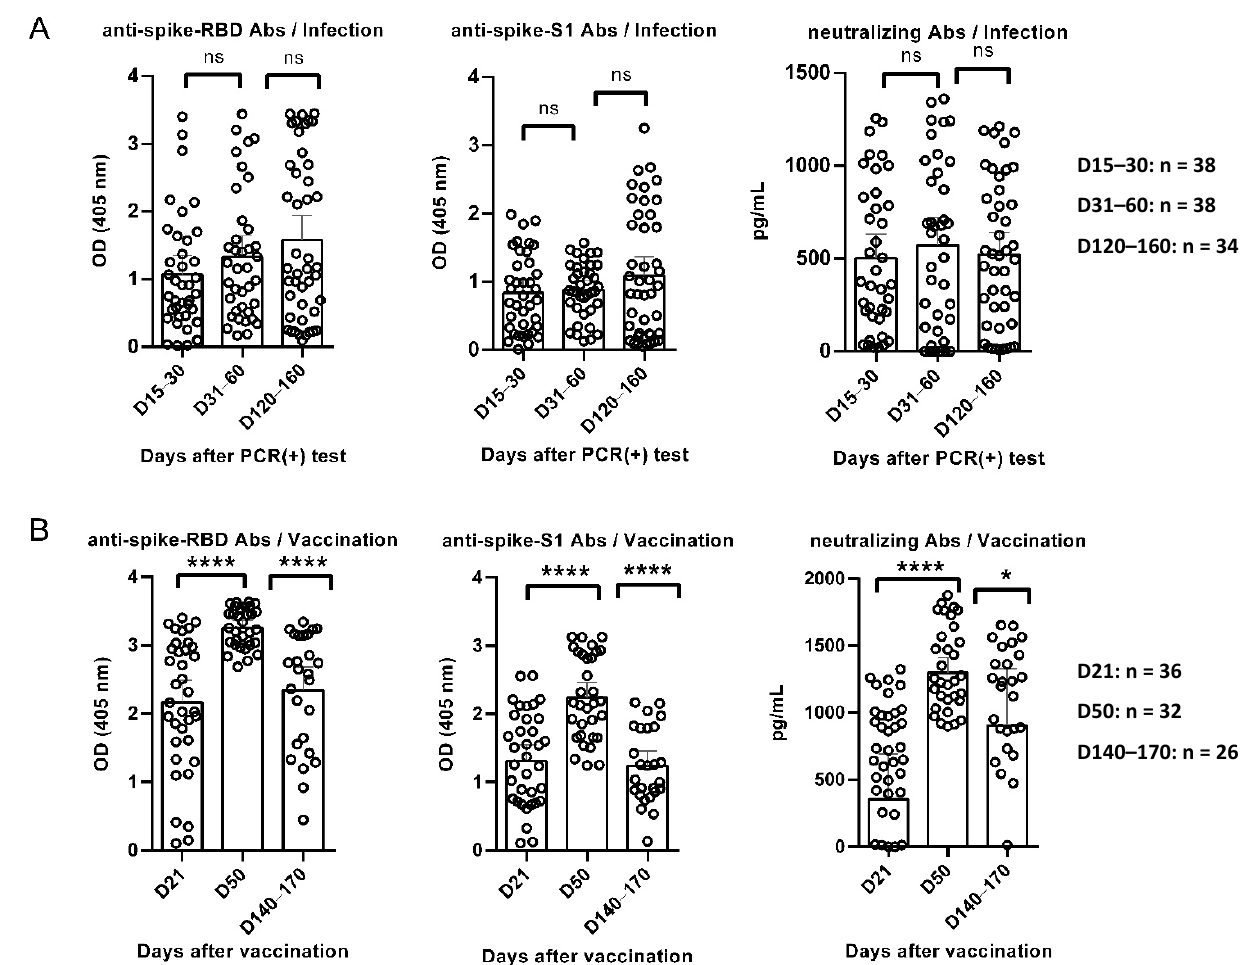
Figure 1. Kinetics of anti-RBD, anti-S1 and neutralizing antibodies (NAbs) in: ( A ) SARS-CoV-2 recovered (D15–30: n = 38, D31–60: n = 38, D120–160: n = 34) and ( B ) vaccinated individuals (D21: n = 36, D50: n = 32, D140–170: n = 26). Diluted sera (1/100 in 2% BSA PBS) were tested against RBD (2.5 µ g/mL) and Spike-protein S1 (1.5 µ g/mL). The cut-off value was determined as the mean optical density plus 2 standard deviations (SD) of a pool of general population age-matched controls. Each symbol represents the optical density of a serum sample at 405 nm. NAbs against SARS-CoV-2 were measured using the Abclonal SARS-CoV-2 Neutralizing Antibody Screening Kit (RBD) (RK04149), following manufacturers’ instructions. NAbs are measured in pg/mL. * p < 0.05, **** p < 0.0001, ns: not significant.